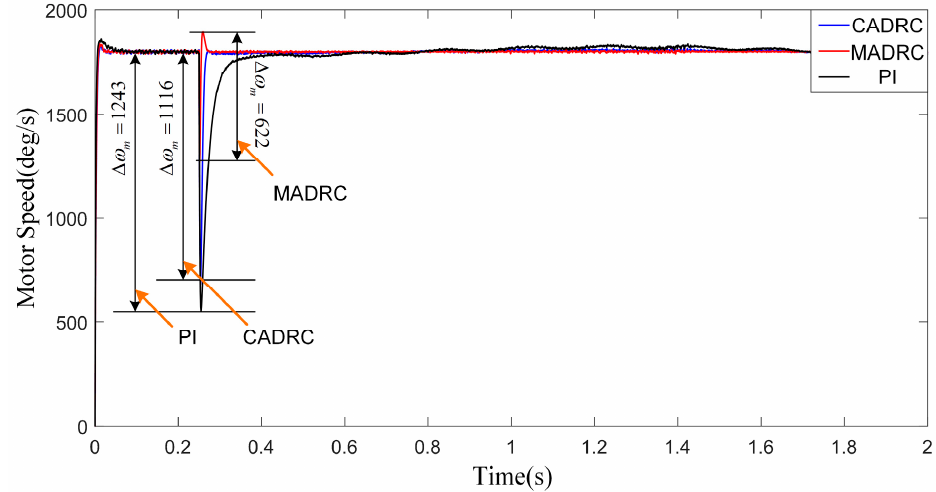
Figure 7. CADRC, MADRC, and PI response curves.